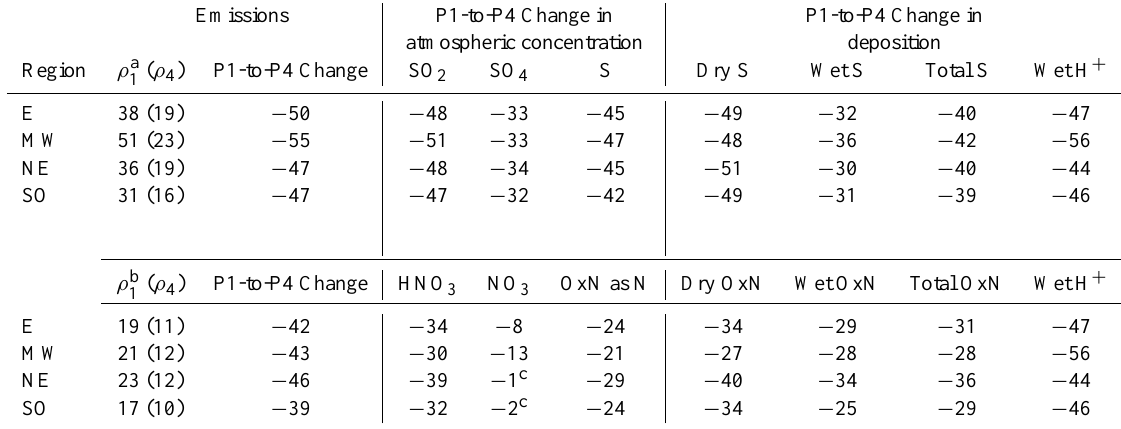
Table 4. P1 and P4 emissions density and P1-to-P4 relative changes (%) in oxidized sulfur and nitrogen emissions, atmospheric concentration, and dry, wet, and total deposition. Emissions P1-to-P4 Change in P1-to-P4 Change in atmospheric concentration deposition Region ρ a ( ρ 4 ) P1-to-P4 Change SO 2 SO 4 S Dry S Wet S Total S Wet H 1